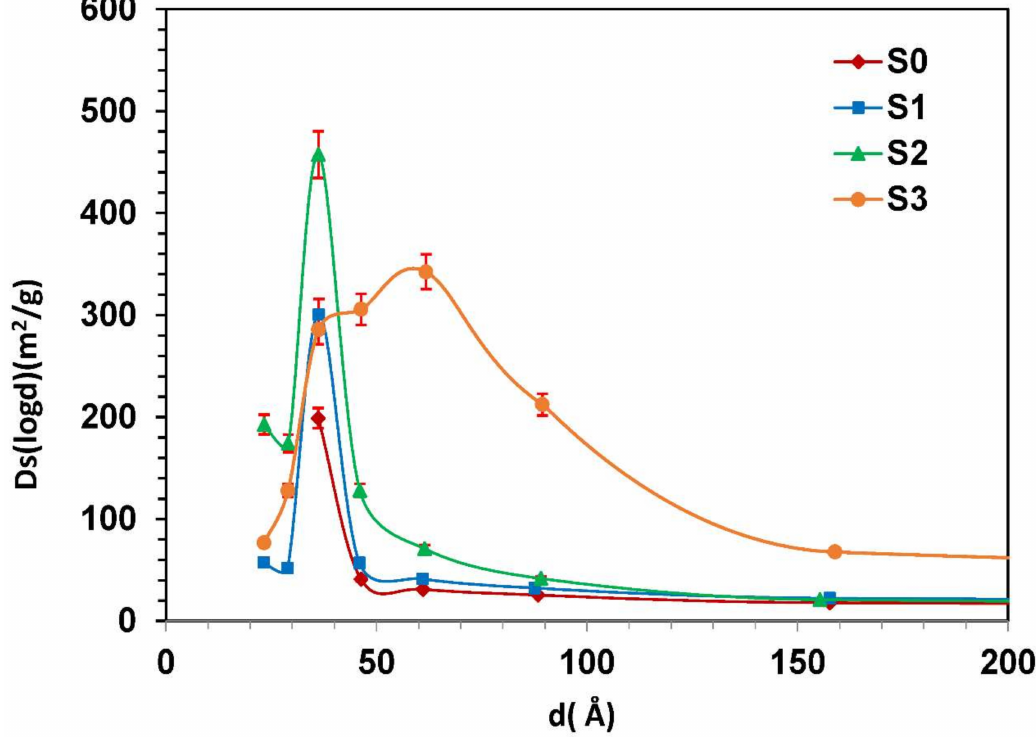
Figure 10. Pore size distribution curves of the raw material ( S 0 ) and activated clays ( S 1 , S 2 , S 3 ) with ± 5% error